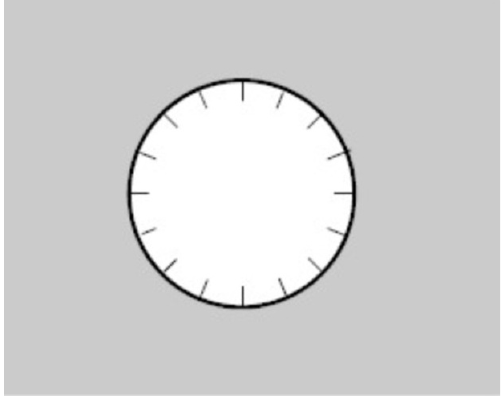
Figure 22 . The complement of disc. Four external particles that give rise to four wave functions. They are written by means of discs or half-(cid:12)nite region functional integrals. The objects sit along the edges of the discs. We can use as well as disc’s complement of a disc. In fact the region outside the disc is the two dimensional region. On this (cid:12)gure we have drawn two layers with the four discs put in as discs and complements.